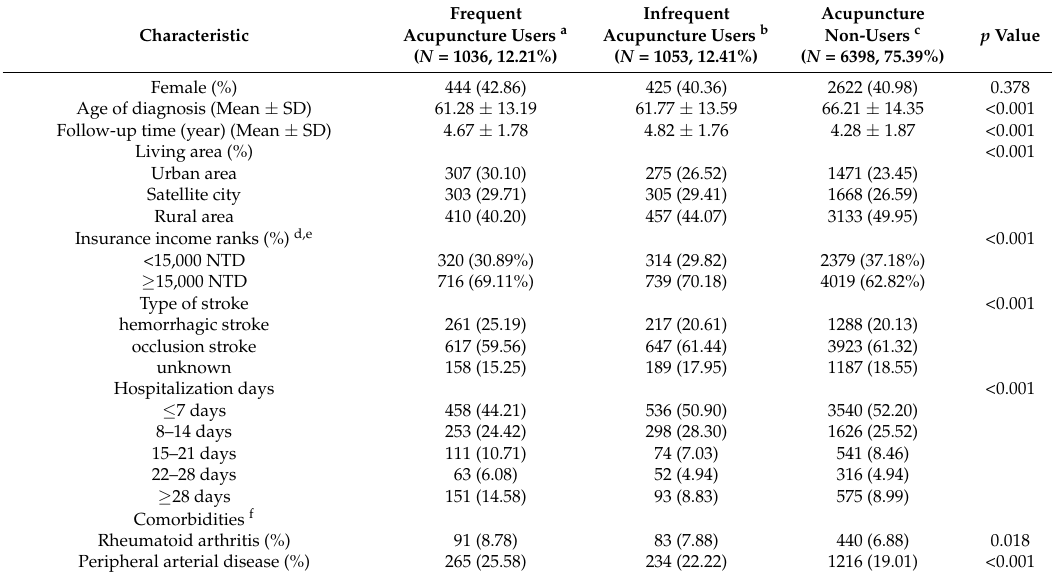
Table 1. Demographic characteristics between frequent, infrequent acupuncture users and non-users in patients using acupuncture with newly diagnosed strokes from the 1-million enrollee random sample of the National Health Insurance Research Database (NHIRD) from 2000 to 2007 in